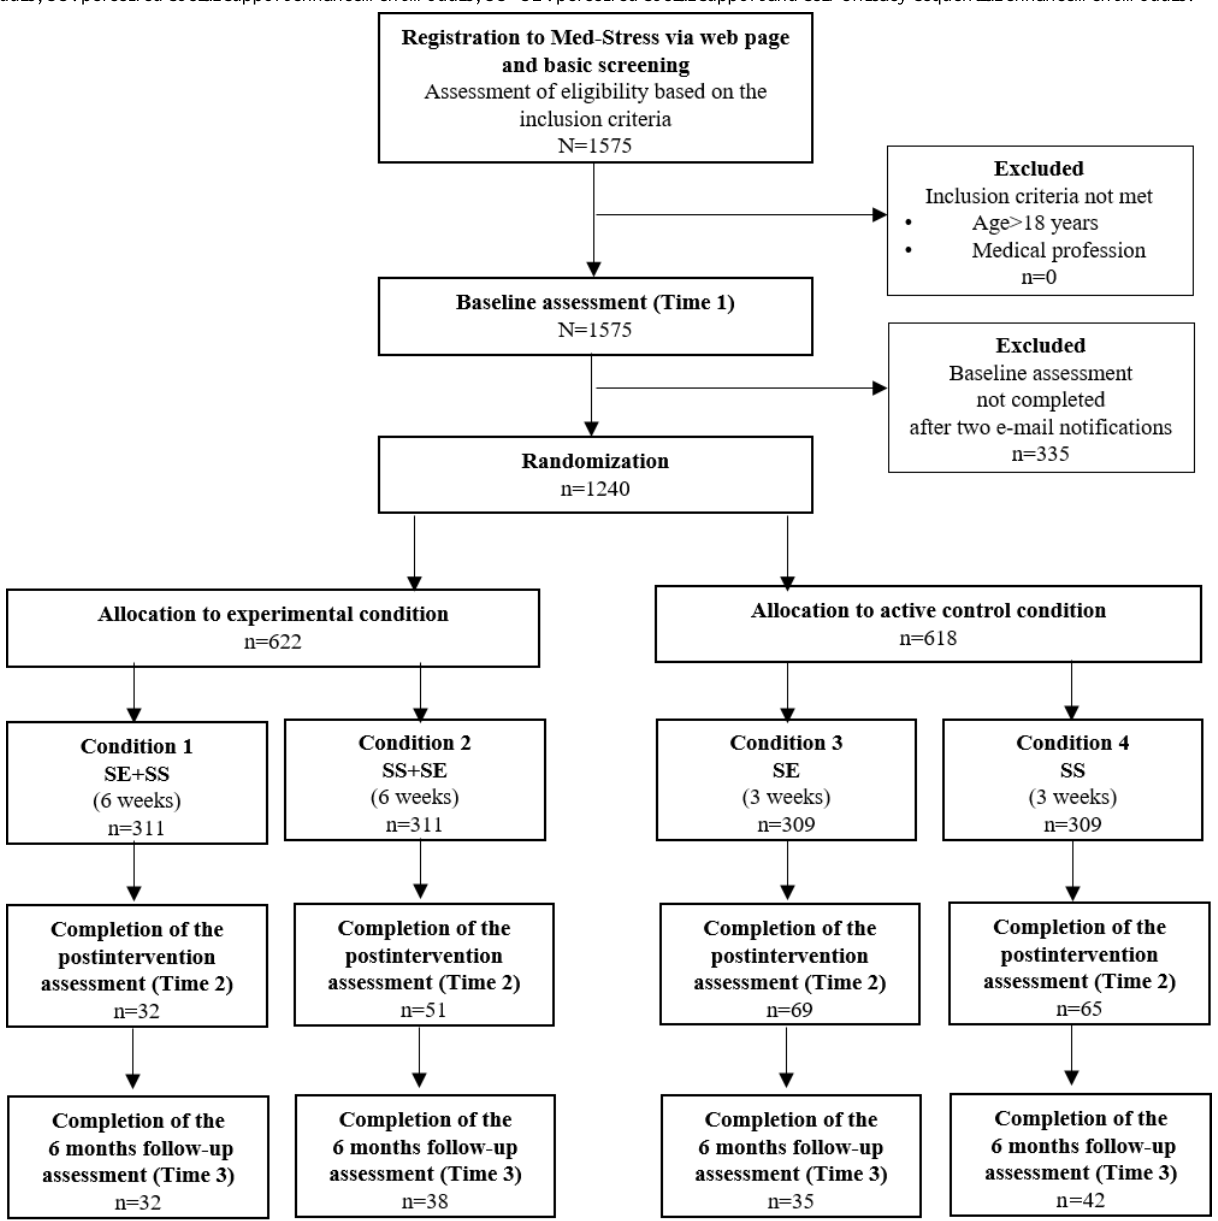
Figure 1. Flow of participants. SE: self-efficacy enhancement module; SE+SS: self-efficacy and perceived social support sequential enhancement module; SS: perceived social support enhancement module; SS+SE: perceived social support and self-efficacy sequential enhancement